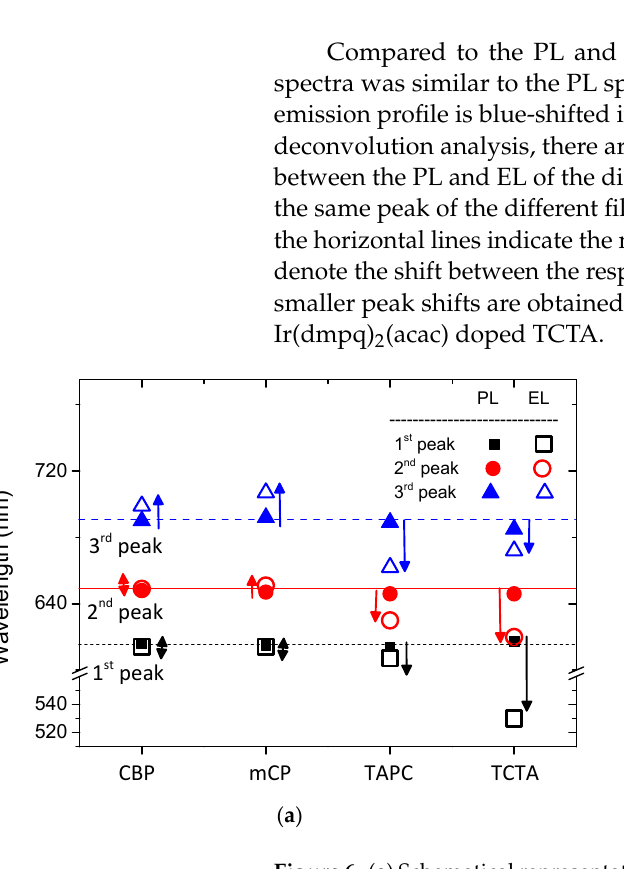
Figure 6. ( a ) Schematical representation of the λ max of the peaks calculated through the deconvolution analysis of the PL and EL emission; ( b ) the CIE color coordinates relative to the PL and EL spectra of the four corresponding